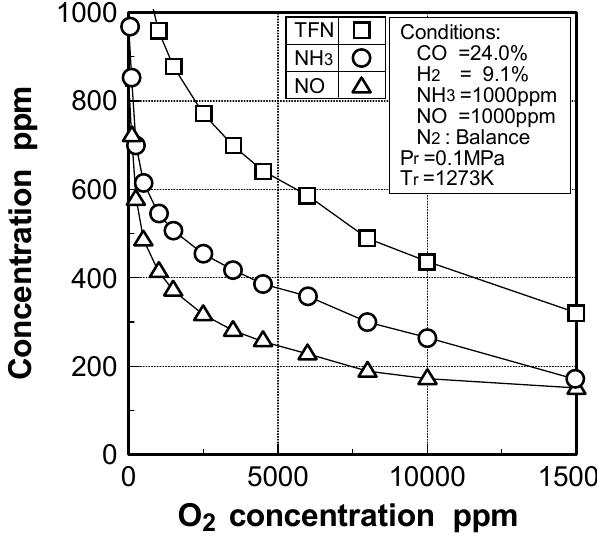
Figure 30. Effect of O gasified fuel as defined by